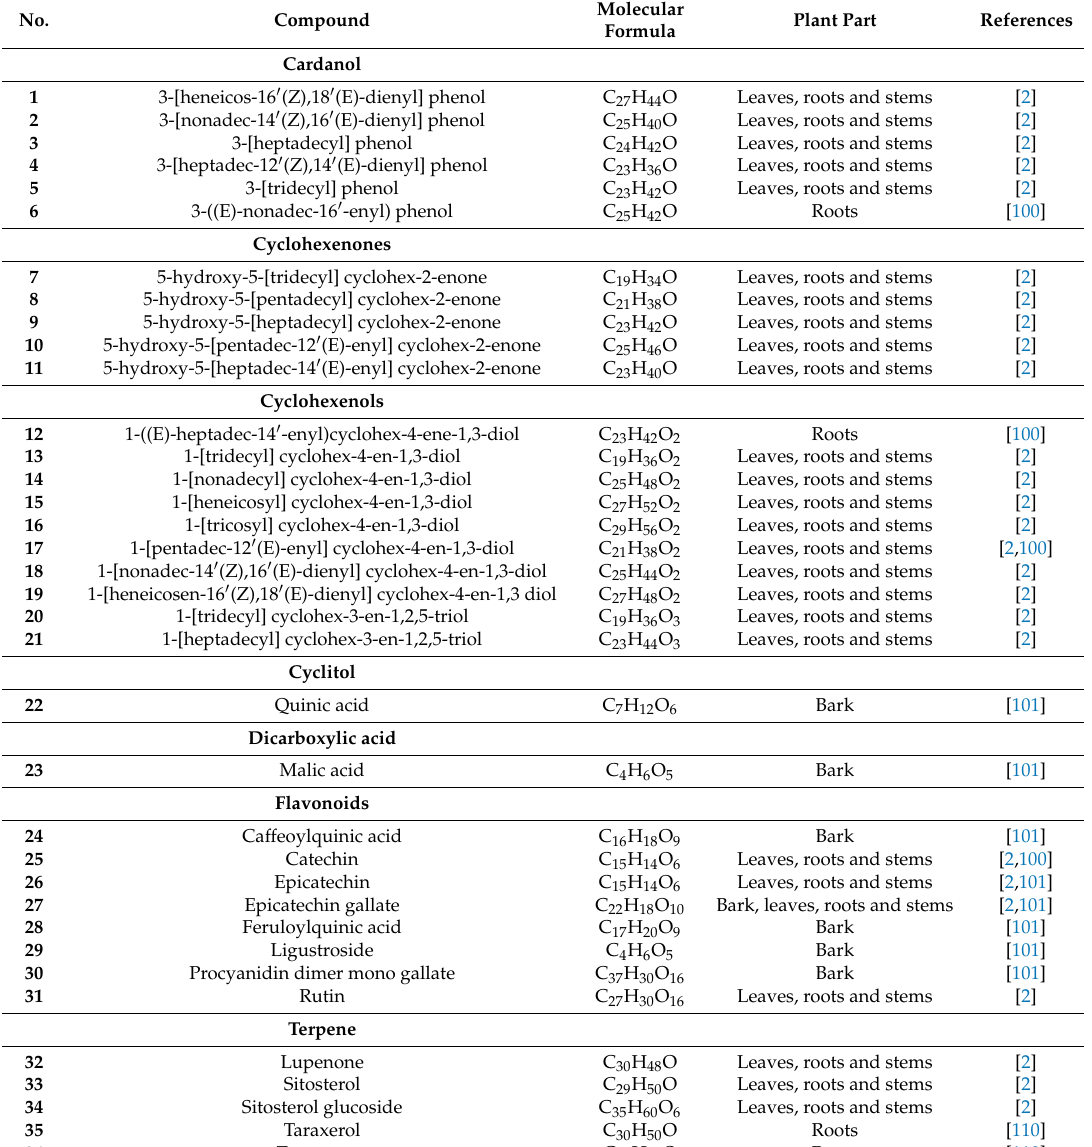
Table 3. Phytochemical compounds identified from Lannea schweinfurthii